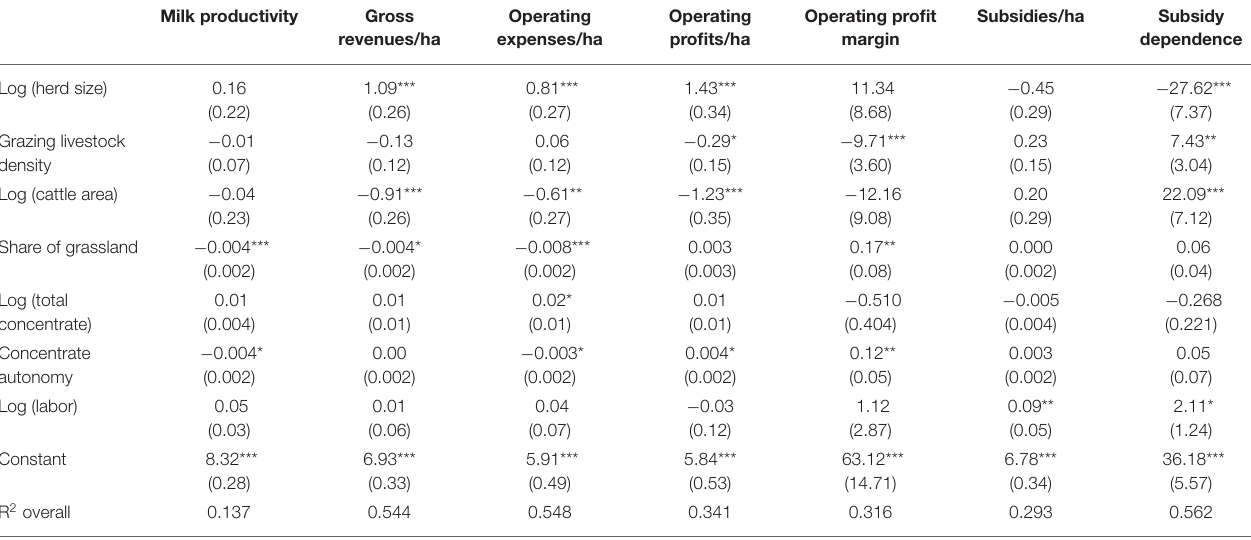
TABLE 3 | Random effects regression analysis for the dairy sector—(dependent variables per hectare) ( N = 324).